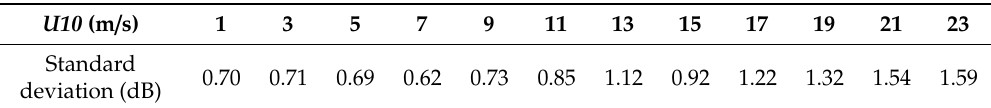
Table 2. The standard deviations of calculated SNR and TDS-1 SNR